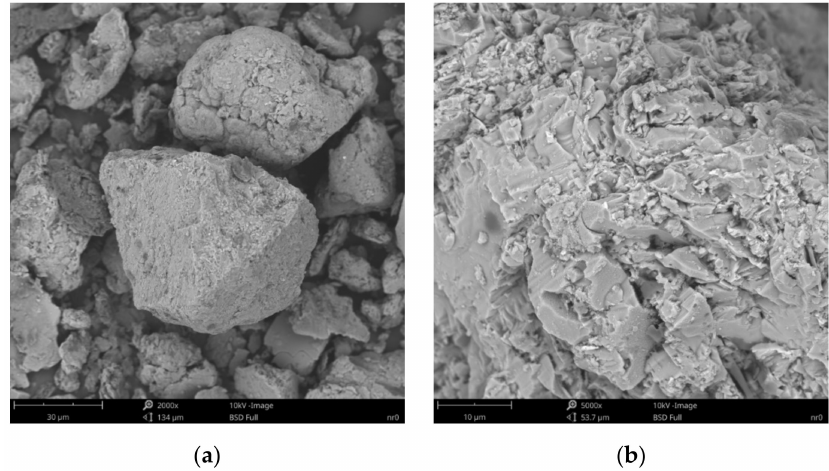
Figure 8. SEM images of particle surfaces for ( a ) SN, magnification: 2000 × , scale bar: 30 µ m; ( b ) SN, magnification: 5000 × , scale bar: 10 µ m.